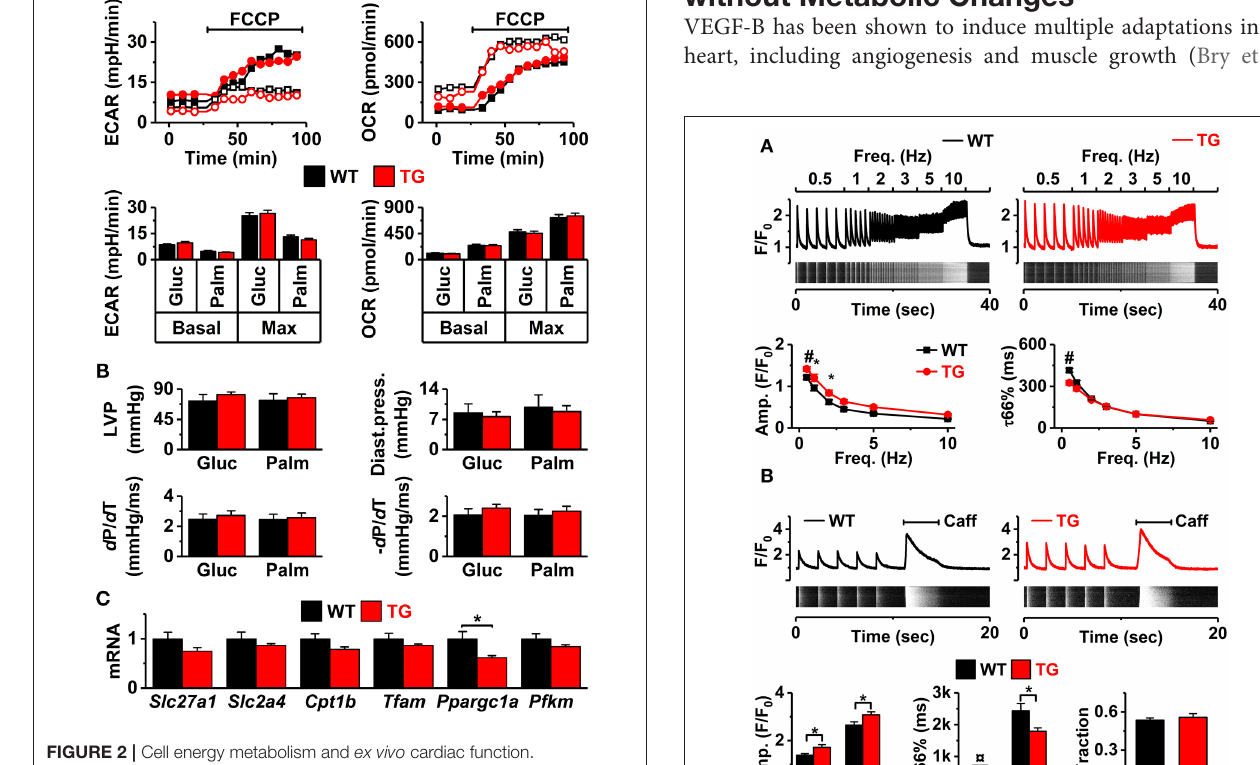
FIGURE 2 | Cell energy metabolism and ex vivo cardiac function. (A) Extracellular acidification and oxygen consumption in isolated cardiomyocytes supplemented with either glucose (Gluc) or palmitate (Palm). Top panels: representative plots of extracellular acidification rate (ECAR, left) and oxygen consumption rate (OCR, right). Bottom panels: basal and FCCP-induced maximal ECAR (left) and OCR [right, n = 35 wells with ∼ 2,000 cells each, from seven (7 WT and 7 TG mice) independent paired assays]. (B) Ex vivo systolic heart function in glucose- (Gluc) and palmitate-based (Palm) solutions. Systolic pressure (LVP, upper left), diastolic pressure (Diast.press., upper right), systole rise slope (dP/dT, lower left), and systole decay slope ( − dP/dT, lower right, n = 6 in both groups). (C) Ventricular expression of the genes (normalized to WT) related to energy metabolism: fatty acid transporter ( Slc27a1 ), glucose transporter ( Slc2a4 ), carnitine palmitoyltransferase 1B ( Cpt1b ), mitochondrial transcription factor A ( Tfam ), muscle phosphofructokinase ( Pfkm ), and peroxisome proliferator-activated receptor gamma coactivator 1-alpha ( Ppargc1a ) (WT n = 7 and TG n = 6) * P < 0.05.